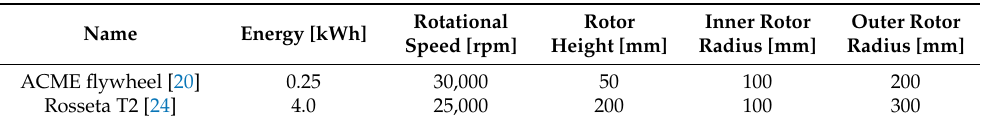
Table 6. Rotor specifications used for the case